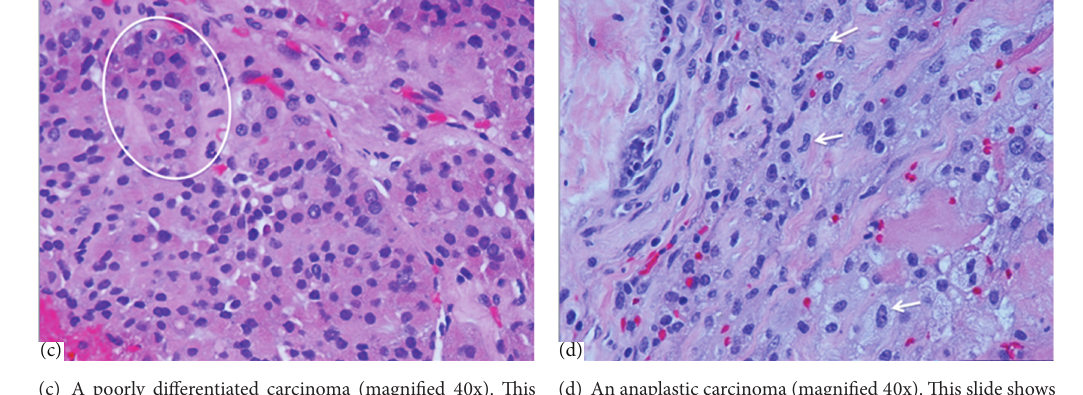
Figure 2: These slides illustrate the various histologic features of well-differentiated thyroid carcinomas (WDTCs), poorly differentiated thyroid carcinomas (PDTCs), and anaplastic thyroid carcinomas